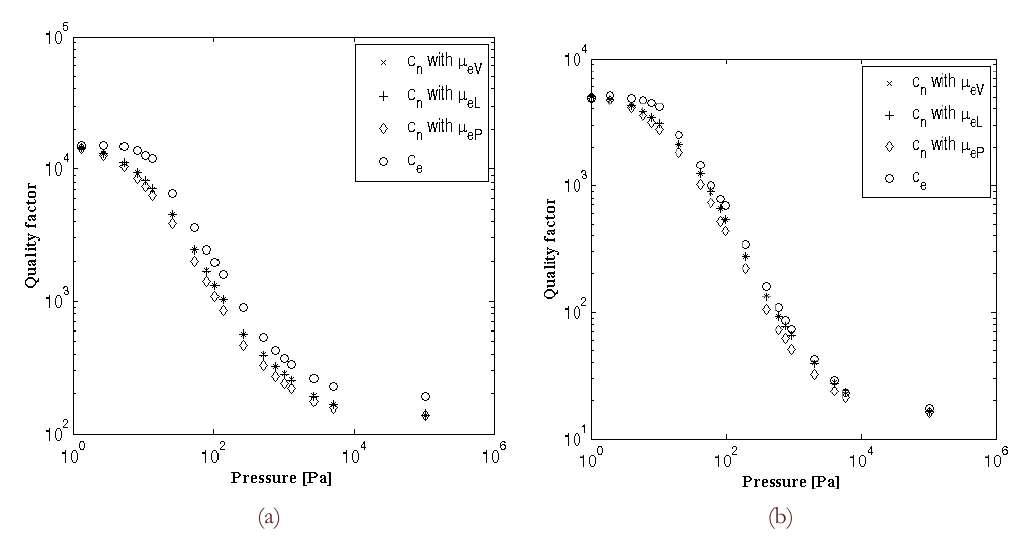
Figure 7: Comparison of the numerical results with the experimental data for micromirror 1(a) and 2 (b) reported by Minikes et al [17].